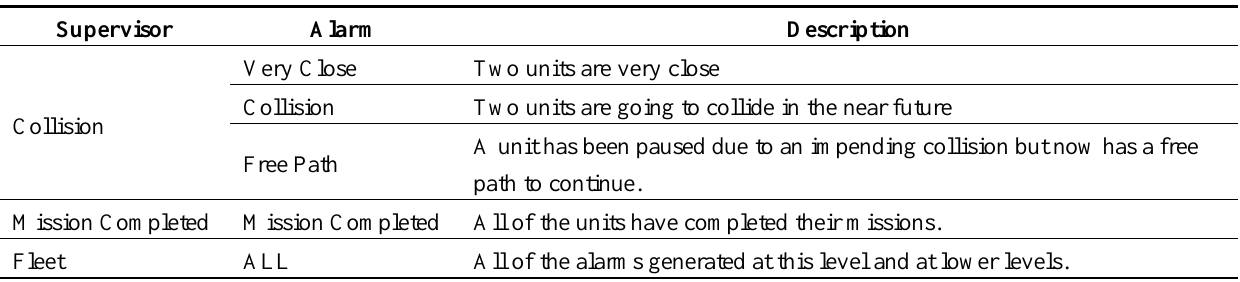
Table 4. Fleet-level supervisor alarms.